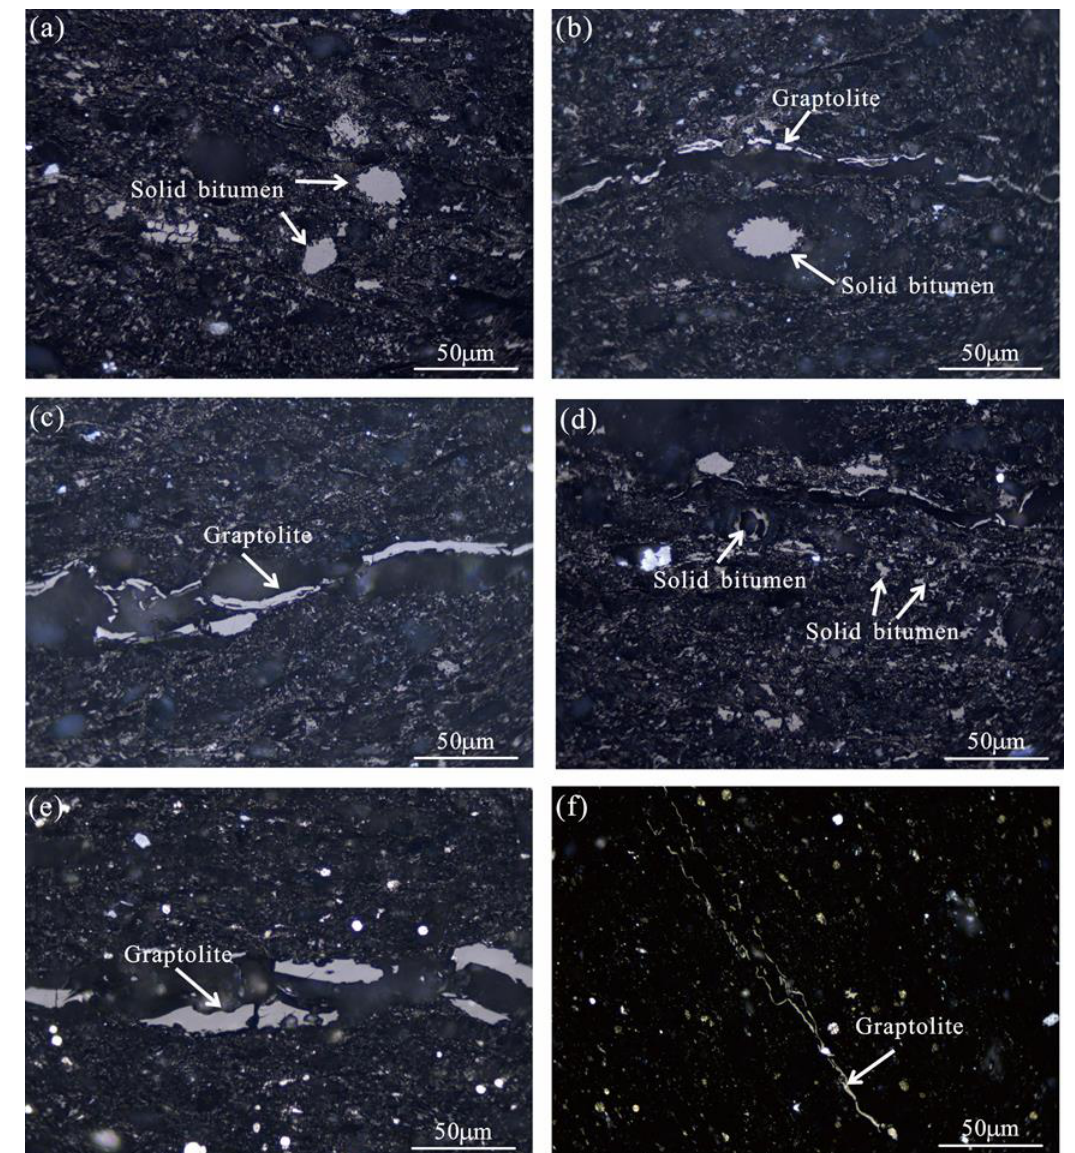
Figure 3. Photomicrographs showing the organic components of the Longmaxi shales. ( a ), XH-27, solid bitumen; ( b ) XH-25, solid bitumen and non-granular graptolites; ( c ) XH-25, non-granular graptolites; ( d ) XH-27, solid bitumen; ( e ) XH-13, non-granular graptolites; ( f ) XH-9, non-granular graptolites.